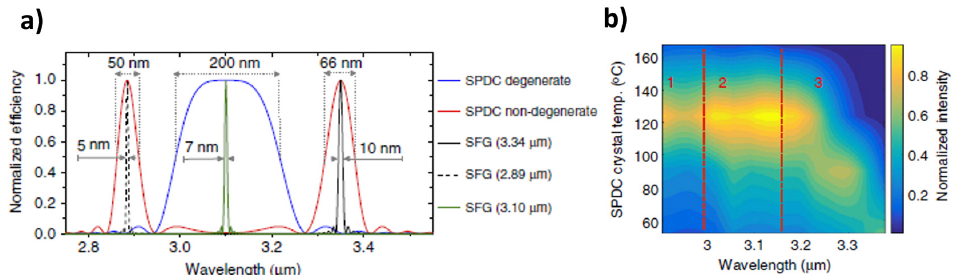
Figure 12. ( a ) Simulation of the SPDC spectra and module bandwidth for the degenerate downconversion process around 3.1 mm, which is obtained at 135 °C (solid blue curve) and for the non-degenerate downconversion process, obtained at 68 °C (solid red curve). ( b ) Experimental spectrum of the SPDC process as a function of the temperature of the SPDC crystal; the labels 1,2,3 in the figure indicate areas with different poling periods of the SFG crystal in the detection module, used to scan the wavelength. Adapted and reproduced with permission from [59], copyright 2017.